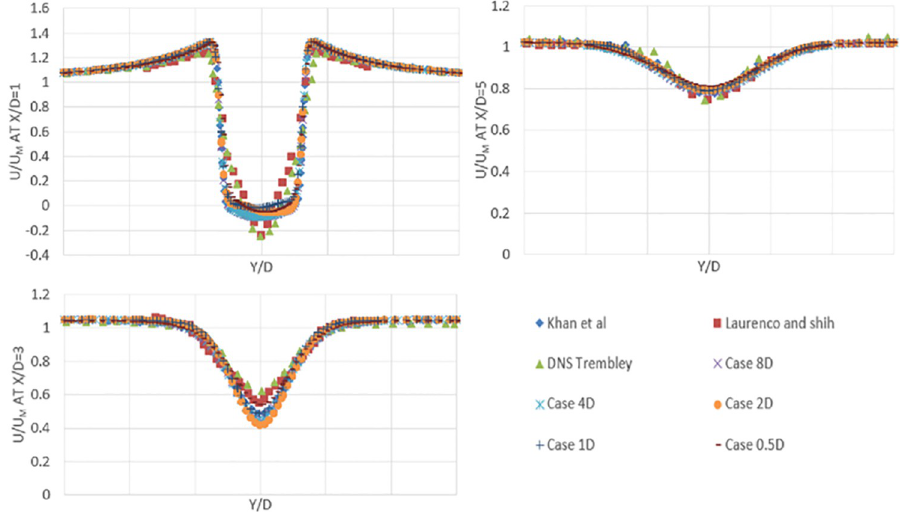
Fig 6. Comparison of mean stream velocity profiles of flow over cylinder at X/D = 1,3 and 5 for present study and other numerical and experimental